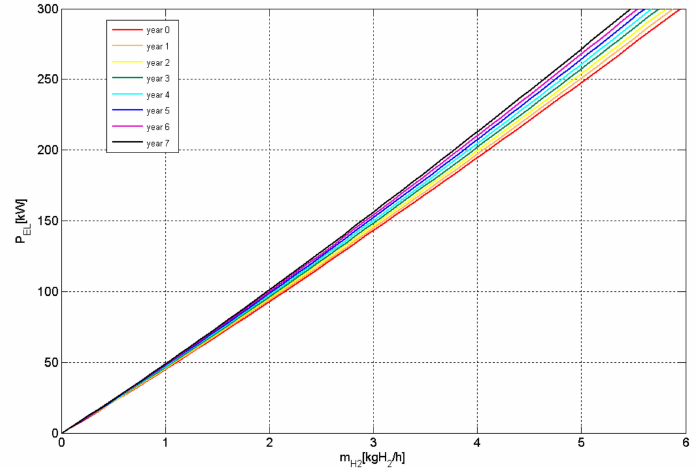
Figure 5. Influence of the years of operation on the fuel cell power curve—own study.